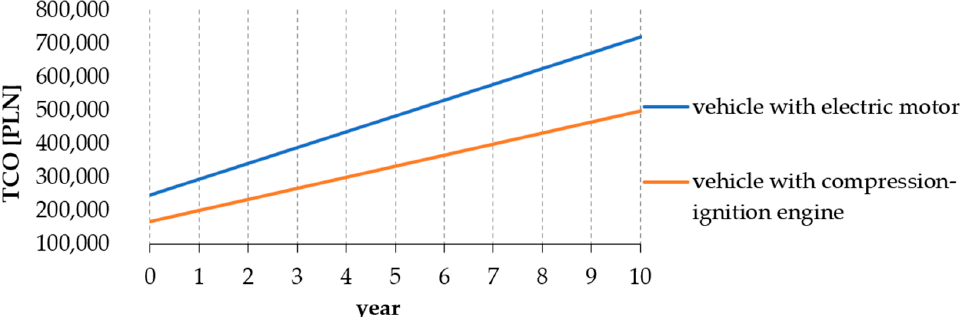
Figure 24. Total cost of ownership of vehicle during the whole operating period—electric vehicle is recharged only at public DC charging stations (the lowest price for 1 kWh was included in the calculations—Scenario B4).